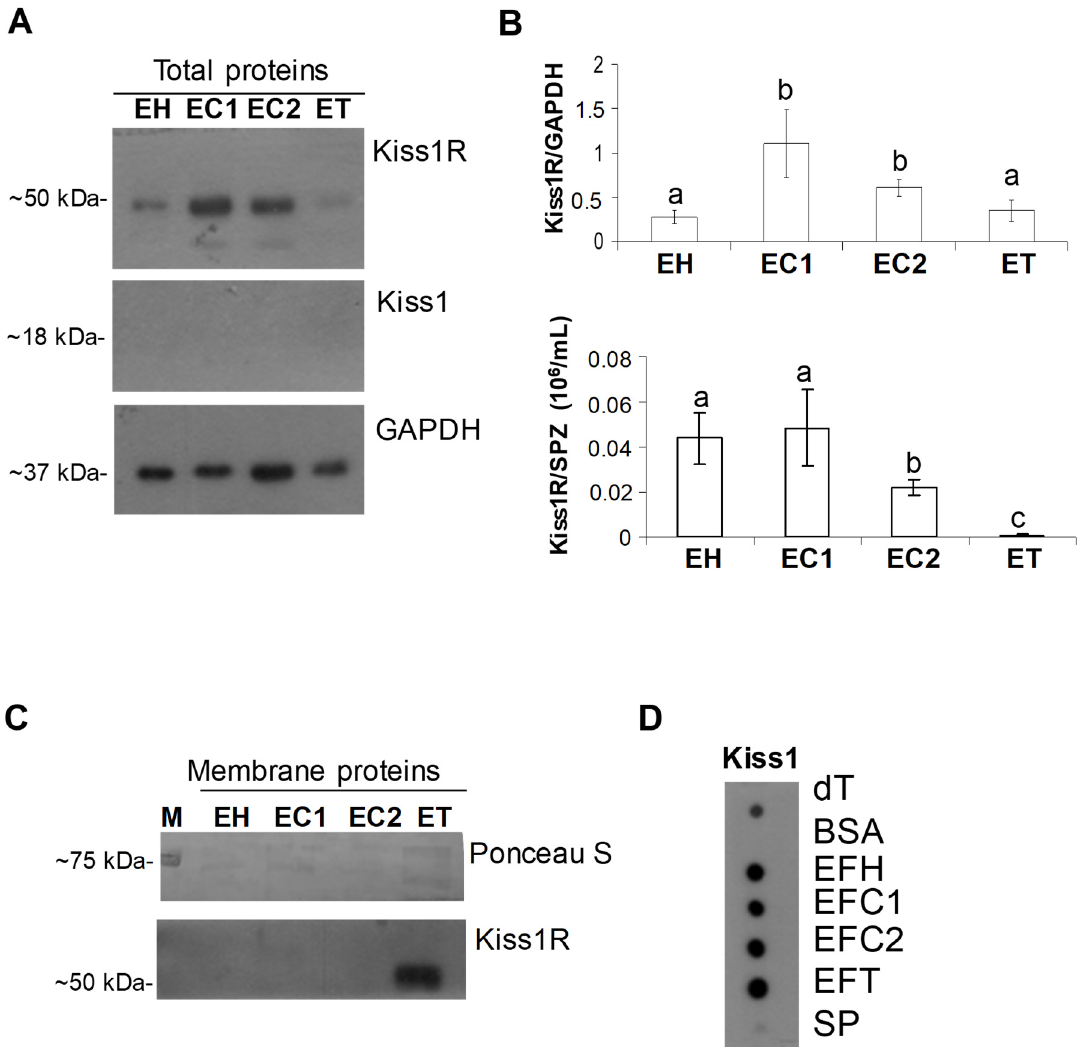
Figure 2. Kisspeptin system in dog sperm and epididymis fluid. ( A ) Representative Western blot of Kiss1R and Kiss1 carried out on total protein extracts from sperm collected at different tracts of the epididymis. ( B ) Protein levels were normalized against GAPDH (upper panel) and then against the SPZ count (lower panel) and data were reported as Kiss1R/GAPDH ± S.D (upper panel) and normalized Kiss1R/SPZ number (10 6 /mL) ± S.D (low panel) ( N = 4). ( C ) Western blot for Kiss1R carried out on crude membrane fraction ( N = 3). ( D ) Representative dot blot for Kiss1 carried out on epididymis fluid and spermatozoa-free seminal plasma ( N = 4). BSA = bovine serum albumin; dT= dog testis, EH: epididymal head sperm; EC1: sperm from the cranial portion of epididymal corpus; EC2: sperm from the caudal portion of the epididymal corpus; ET: epididymal tail sperm; EFH: epididymis fluid from the epididymal head; EFC1: epididymis fluid from the cranial portion of the epididymal corpus; EFC2: epididymis fluid from the caudal portion of the epididymal corpus; EFT: epididymis fluid from the epididymal tail; M = protein ladder; SP: seminal plasma without spermatozoa. Different letters indicate statistically significant differences ( p < 0.05).